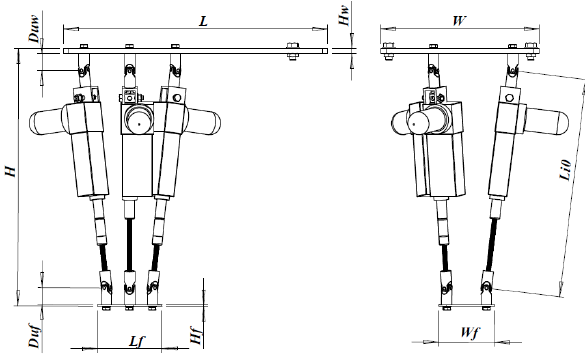
Figure 3. Dimension parameters of the prototype in Fig.